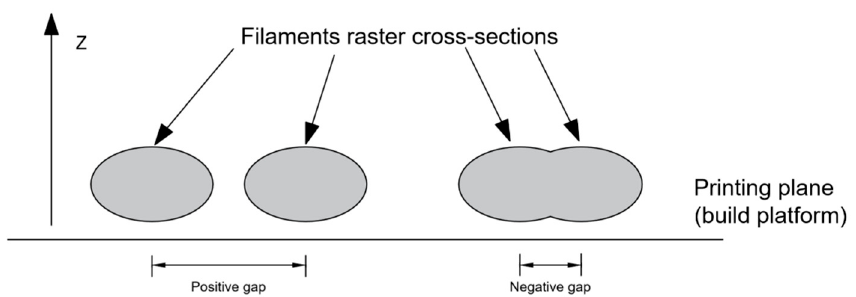
Figure 5. A schematic representation of filament cross-sectional areas, showing the difference between positive and negative gaps.